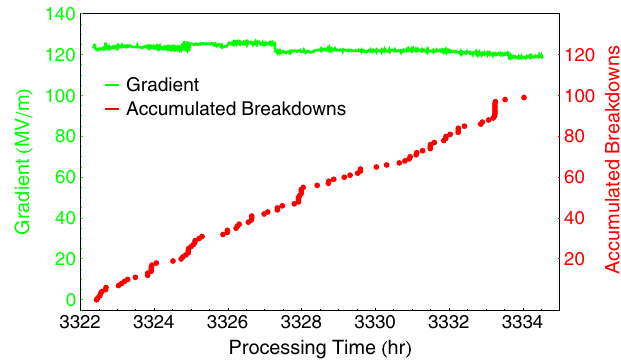
FIG. 15. Accumulated breakdowns and gradient during the majority of